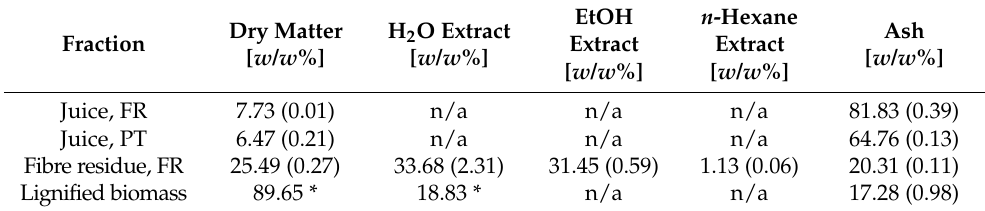
Table 1. Yields of Salicornia ramosissima extracts. Results are given as [ w / w %] on the basis of fresh biomass weight for dry matter content and dry matter weight for extractives and ash. n/a: not available. Results are expressed as mean values with standard deviations (in